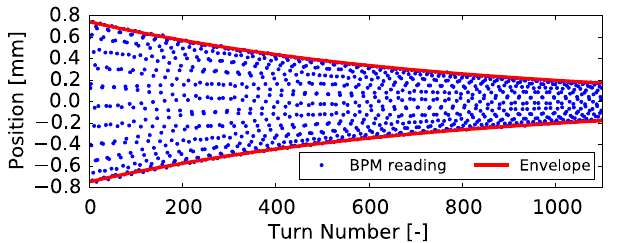
FIG. 7. TbT BPM position readings with estimated exponential envelope.